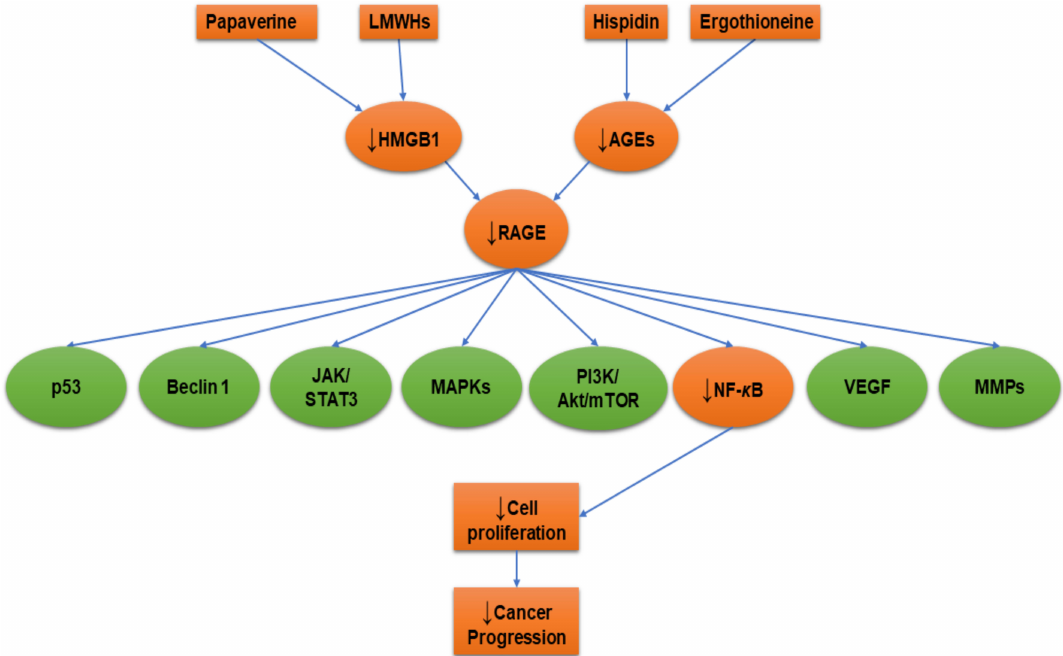
Figure 3. Receptor for advanced glycation end product (RAGE) inhibition with hispidin, ergothioneine, low-molecular-weight heparins (LMWHs), and papaverine. Orange colored shapes refer to the a ff ected cellular molecules due to RAGE inhibition. The arrow pointing down ( ↓ ) means decrease or